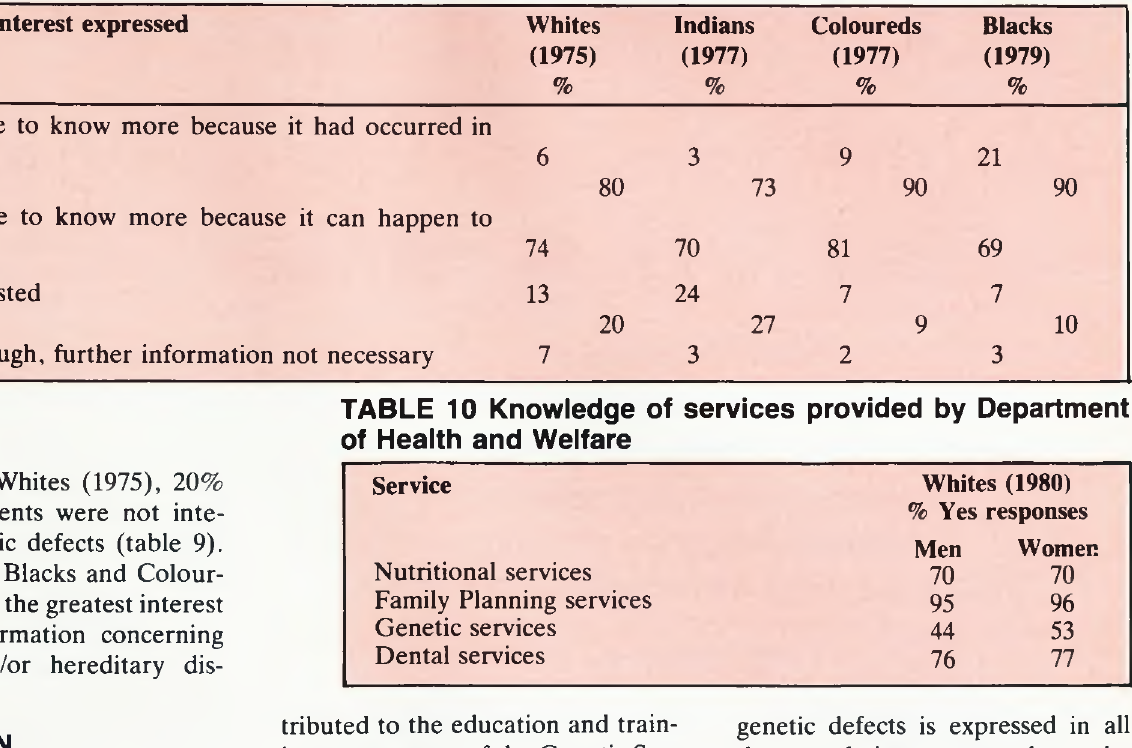
TABLE 10 Knowledge of services provided by